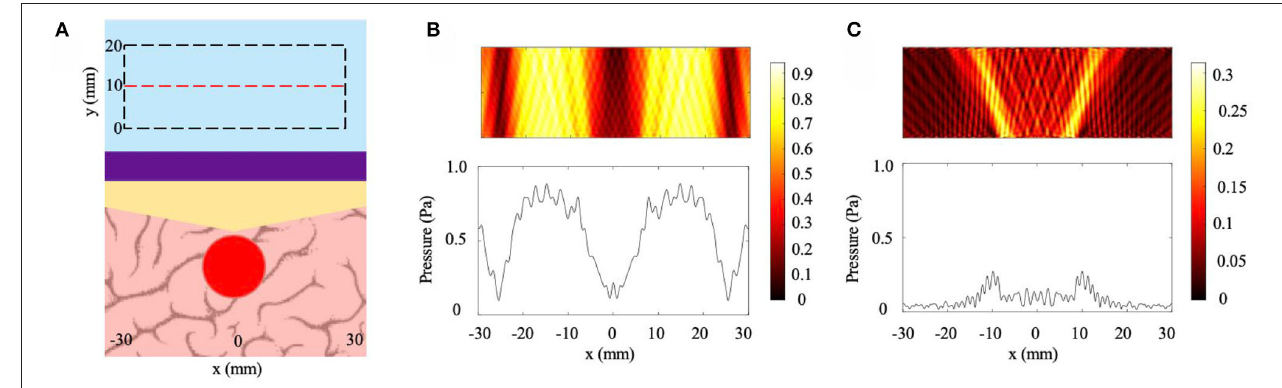
6.67%, peaking in thickness at the center of the ±